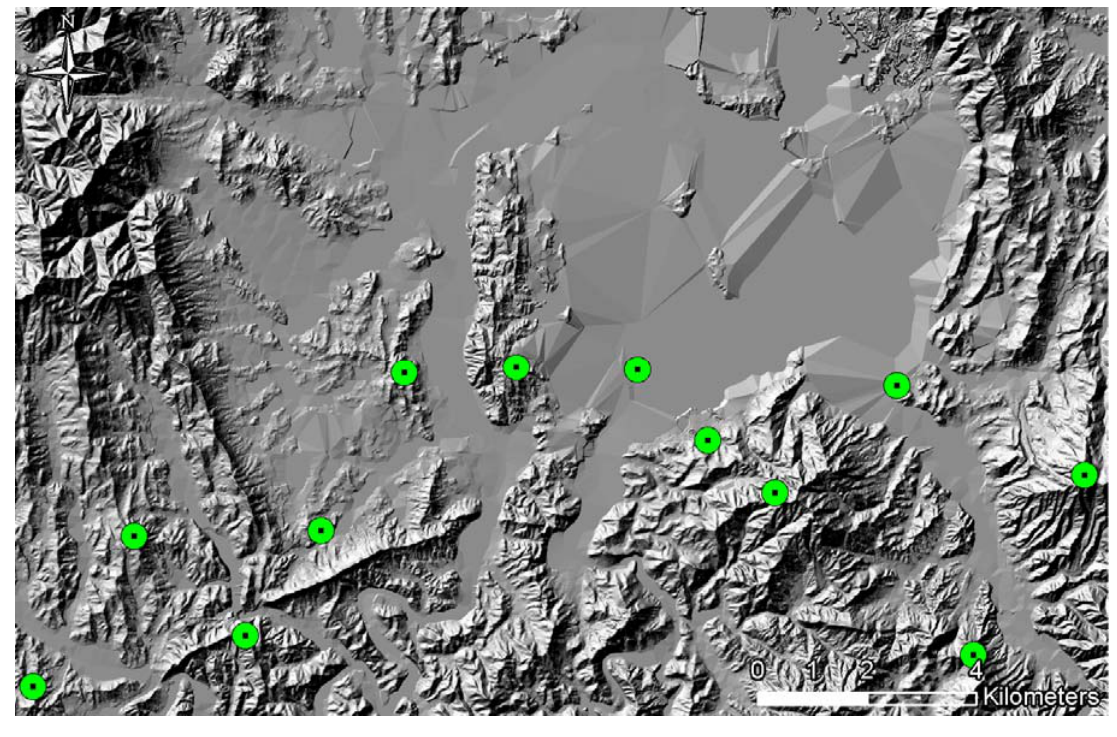
Figure 14. Optimal locations of TODs for vulnerable infiltration routes (from 1,000